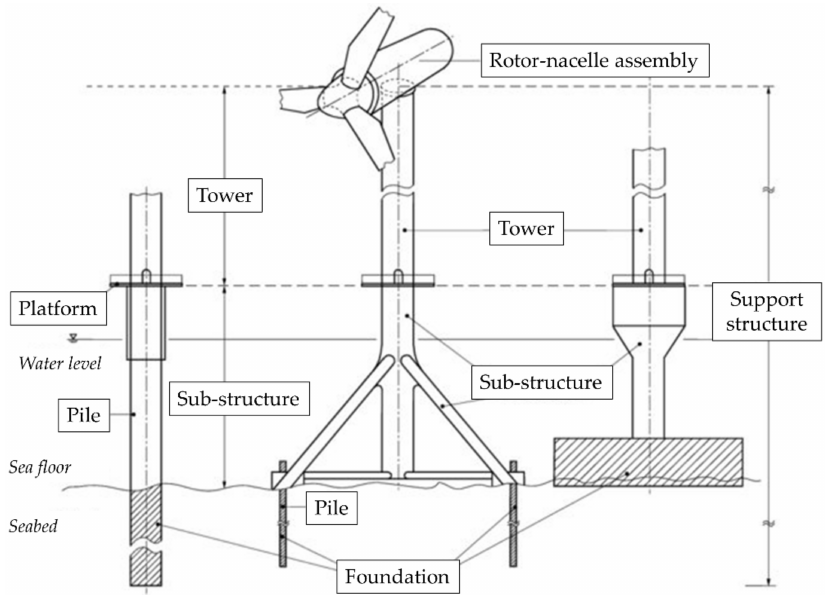
Figure 4. Structural components of a fixed offshore HAWT according to IEC